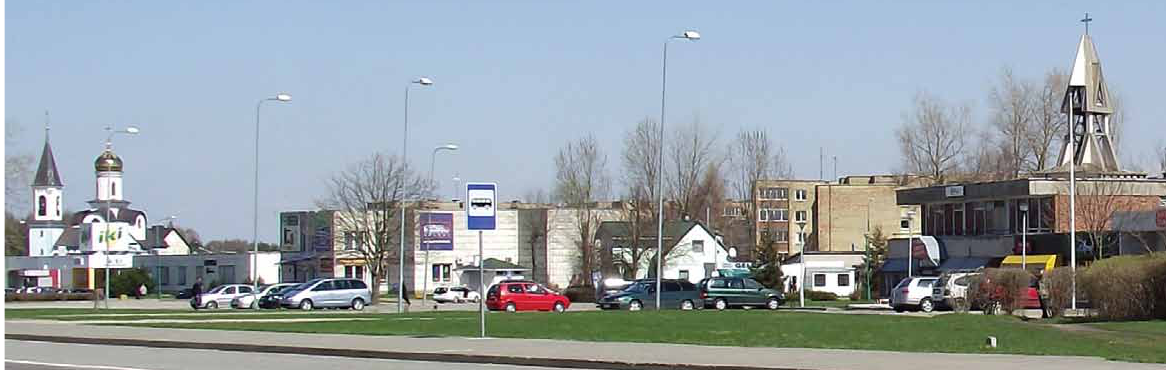
(Saulėtekio takas 1, archit. I. likšienė, G. P. likša, 2005–2006 m.) tapo naujomis kompozicinėmis dominantėmis, l. nekrošiaus nuotr. Fig. 11. The orthodox Church, Sodų g. 52, archit. Dmitrij Borunov (2000–2002) and Evangelical lutheran Church, Saulėtekio takas 1, archit. I. likšienė, G. P. likša (2005–2006) were erected after regaining Independence and became landmarks of former Soviet public centre in Virbališkės residential area, l. nekrošius